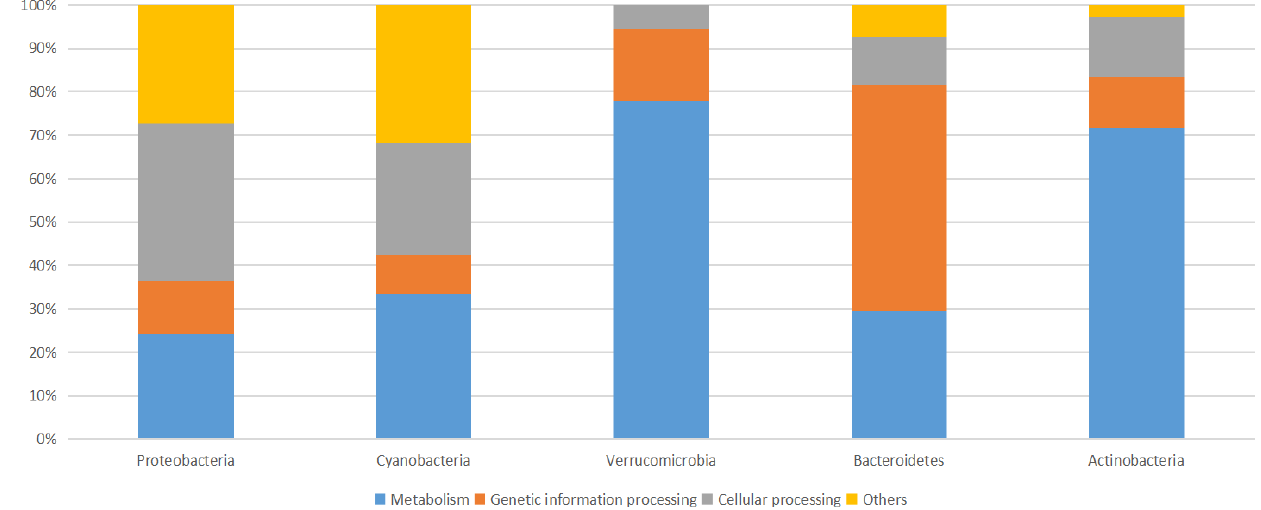
Figure 10. Top functional genes abundance in Marchica using Prokka [24].